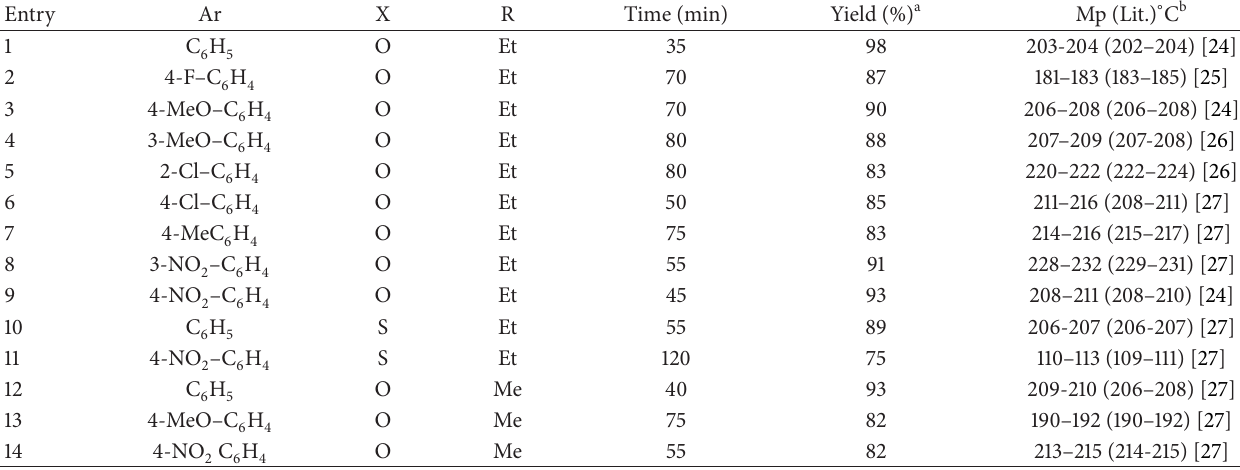
H) Cl with 3 2 2